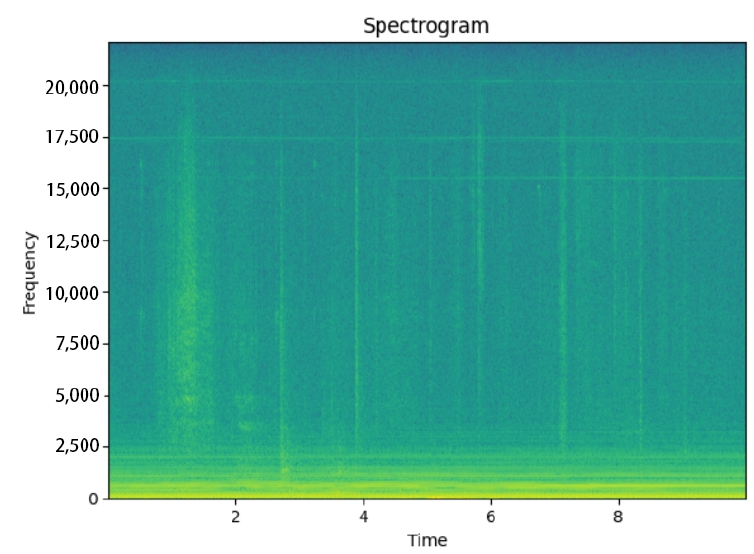
Figure 4. Normal transformer